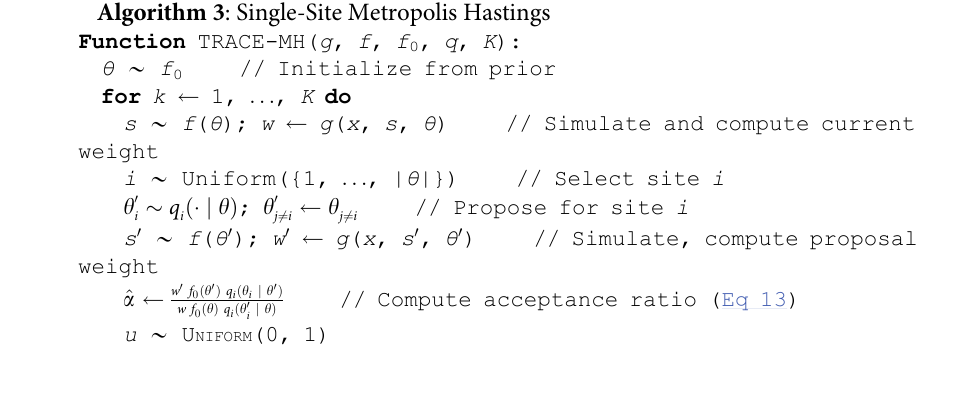
Algorithm 3 : Single-Site Metropolis